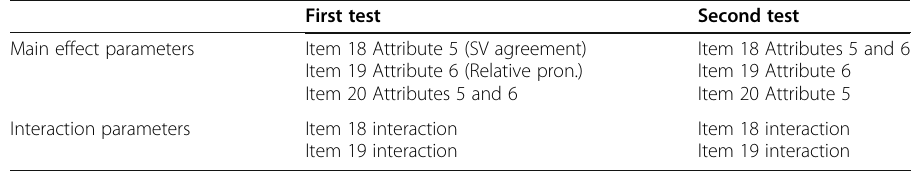
Table 5 Insignificant parameters of main effects and